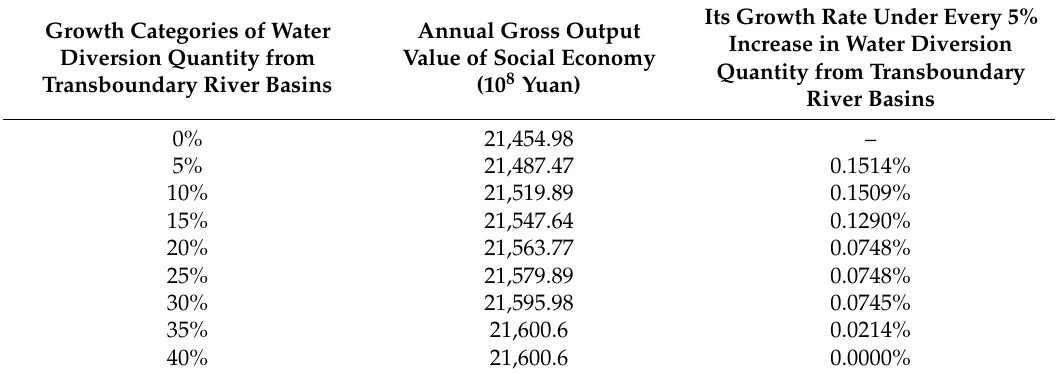
Table 10. Average annual gross output value of social economy and its growth rate under every 5% increase in water diversion quantity from transboundary river